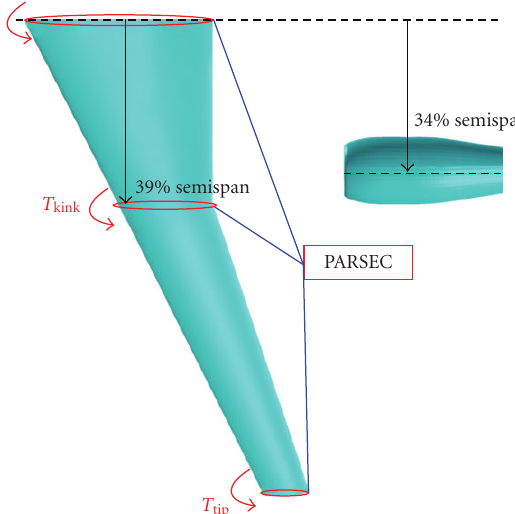
Figure 8: Planform shape, kink position, and nacelle location.